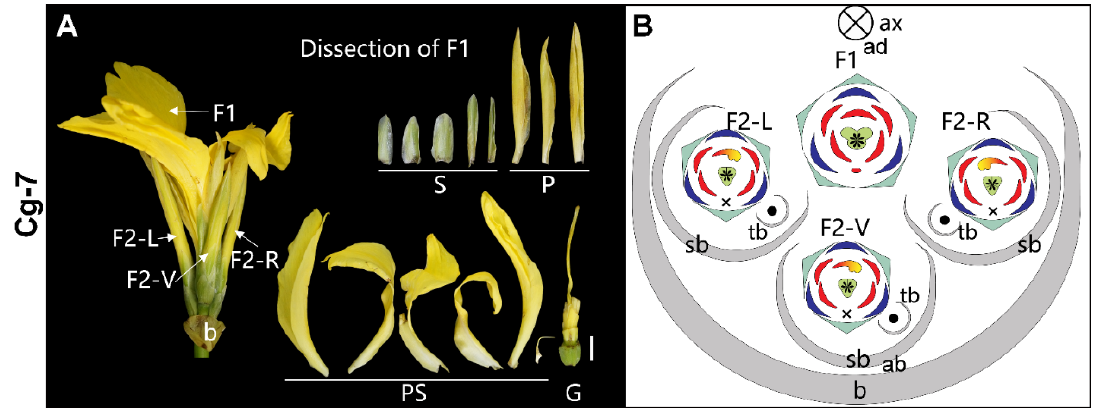
Figure 8. 4-flowered cyme. ( A ) Photograph and ( B ) diagram of the partial inflorescence of Cg-7. F2-V, the ventral secondary flower. Bar = 1 cm.